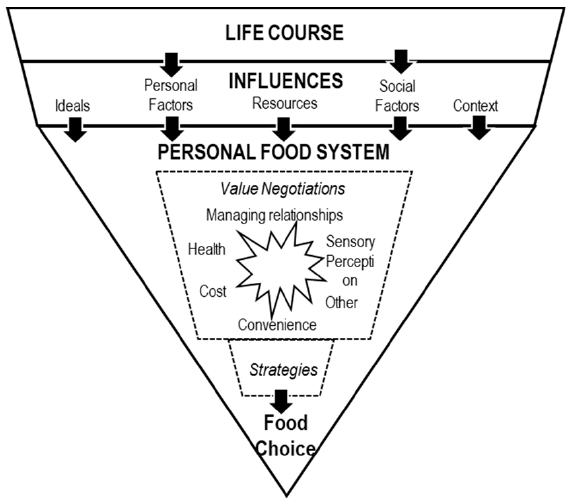
Figure 1. The food choice process model adapted from Furst et al. (1996) [51] and Connors et al. (2001) [60].